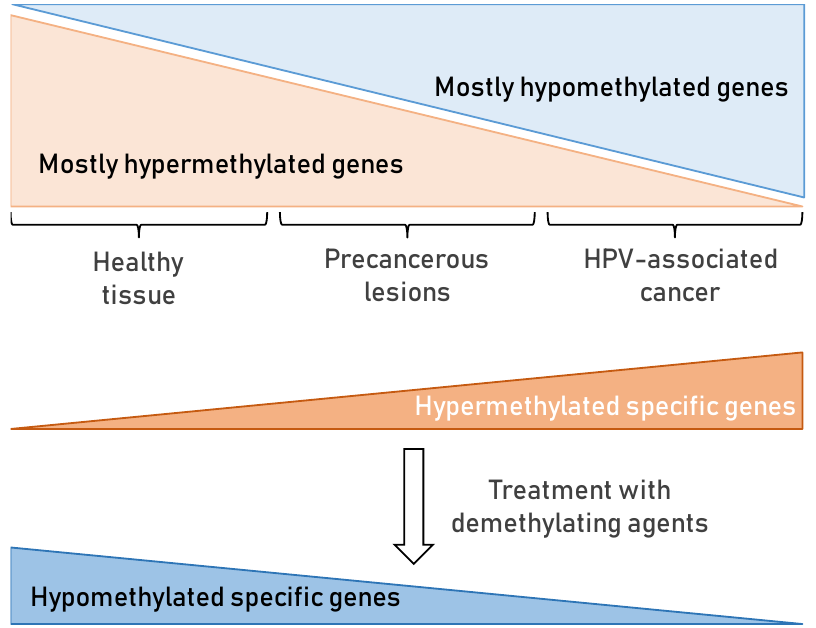
Figure 6. Schematic representation of DNA methylation in HPV-associated cancer. In healthy tissue, DNA methylation occurs often on most cellular gene promoters, resulting in the absence of their expression. In cancer, some relevant genes may become methylated, while most remain unmethyl- ated. Thus, aberrant DNA methylation profile in cancer compared to normal tissue can represent a biomarker for cancer occurrence and even association to HPV infection causing that cancer. Epige- netic drugs, such as demethylating agents (DNA methyltransferase (DNMT) inhibitors), could be used to induce the expression of specific genes that would slow the progression of the cancer and enable restoration of normal phenotype. Hypermethylated genes are presented in orange and hy- pomethylated in blue. 7.3. miRNA in HPV-Associated Cancer Since their discovery in the early 1990s [189], small non-coding RNA (miRNA) mol- ecules have been intensively studied with more than 48,000 sequences described across 270 organisms [190]. The miRNA molecules, approximately ~22nt long, are generated from longer precursors by dedicated protein machinery under tight control [191]. Their primary function is translational repression and degradation of their complementary tar- get mRNA molecules. Thus, they serve a critical role in epigenetic regulation of various essential cellular processes from development to immunity but also play a role in many diseases and conditions [192]. Soon after it was discovered that miRNAs are conserved across different species, the field of “oncomirs”, or cancer-associated miRNA, was estab- lished [193]. It was shown that different cancer types have different miRNA signatures [194], making them promising biomarkers in cancer detection [195]. For a molecule to be a good biomarker, it should be easily accessible, specific, and sensitive [196]. Thus far, miRNA molecules appear to be both specific and sensitive, and further studies demon- strated their stability in easily accessible samples, like blood [197], urine [198], and other body fluids [199,200], as well as stability in formalin-fixed-paraffin-embedded (FFPE) tis- sues [201]. Despite the vast progress in the field of miRNAs as cancer biomarkers, the translation of results to a clinical setting is still challenging and usually lacks reproduci- bility [202]. However, research is still ongoing, and numerous miRNA molecules are in- vestigated for their biomarker potential in many cancer types, including common and rare gynaecological [202,203], head and neck [204], gastrointestinal [205,206], and lung cancer [207]. Herein, the current knowledge regarding miRNAs as biomarkers for CC, which is